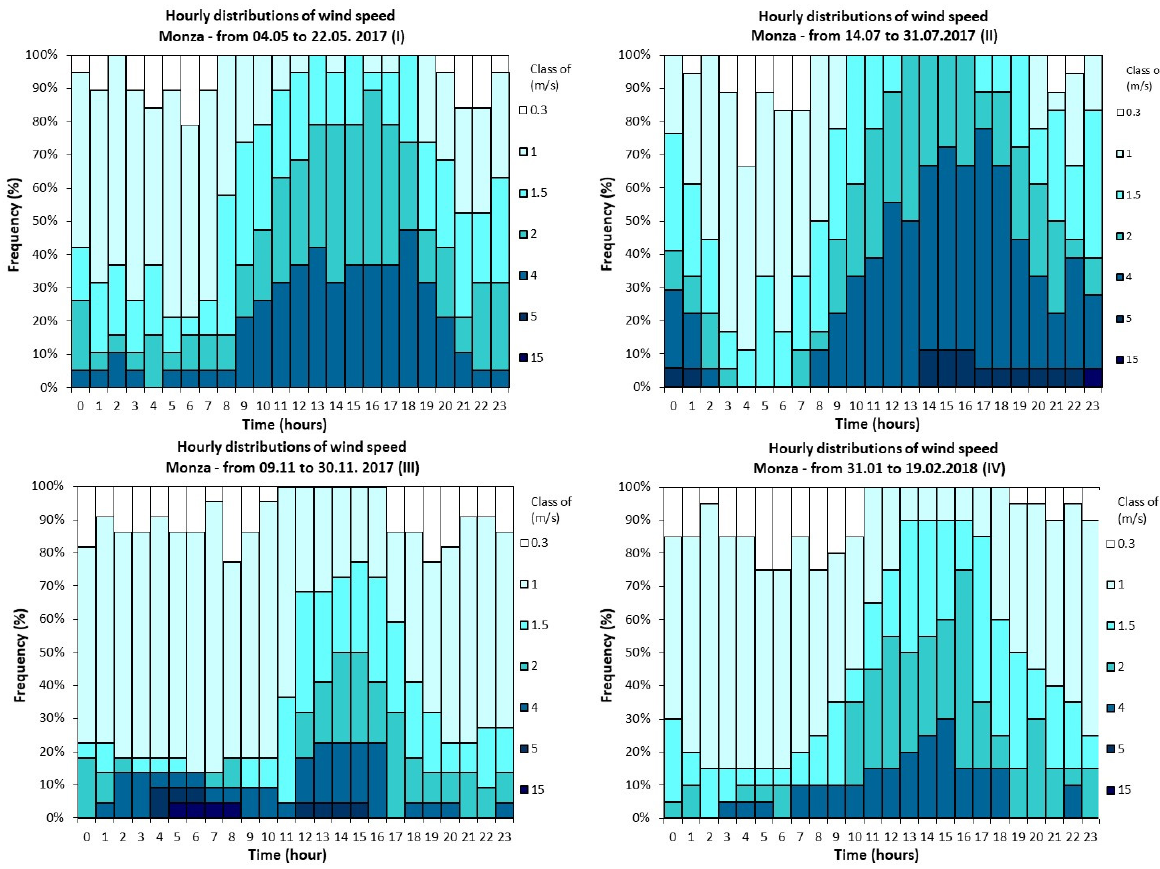
Figure 9: Hourly distributions of the wind speed in the different measurement periods